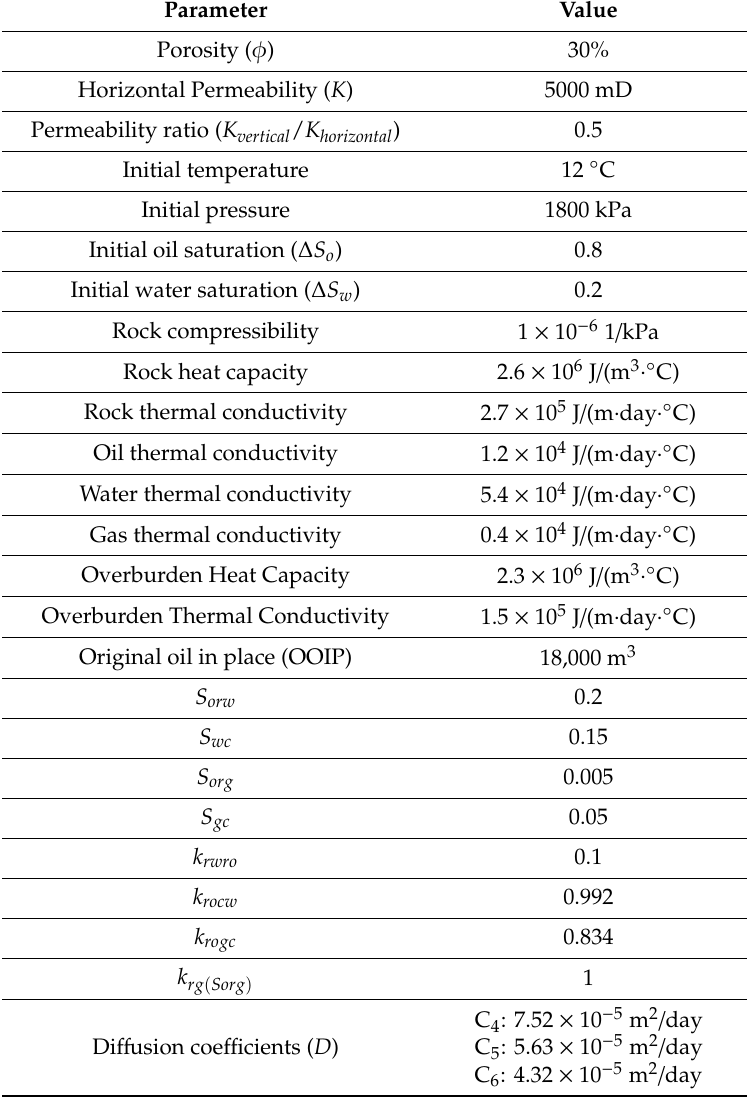
Table 1. Reservoir properties used in the simulation